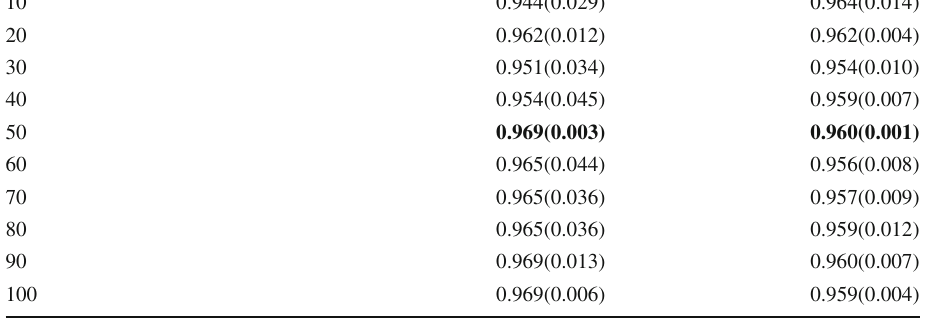
Table 7 Experimental results on the sensitivity of the maximum number of iterations T